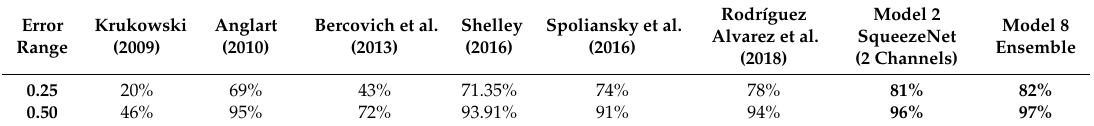
Table 7. Overall accuracy level reported by related works and the developed system (in bold) within different human error